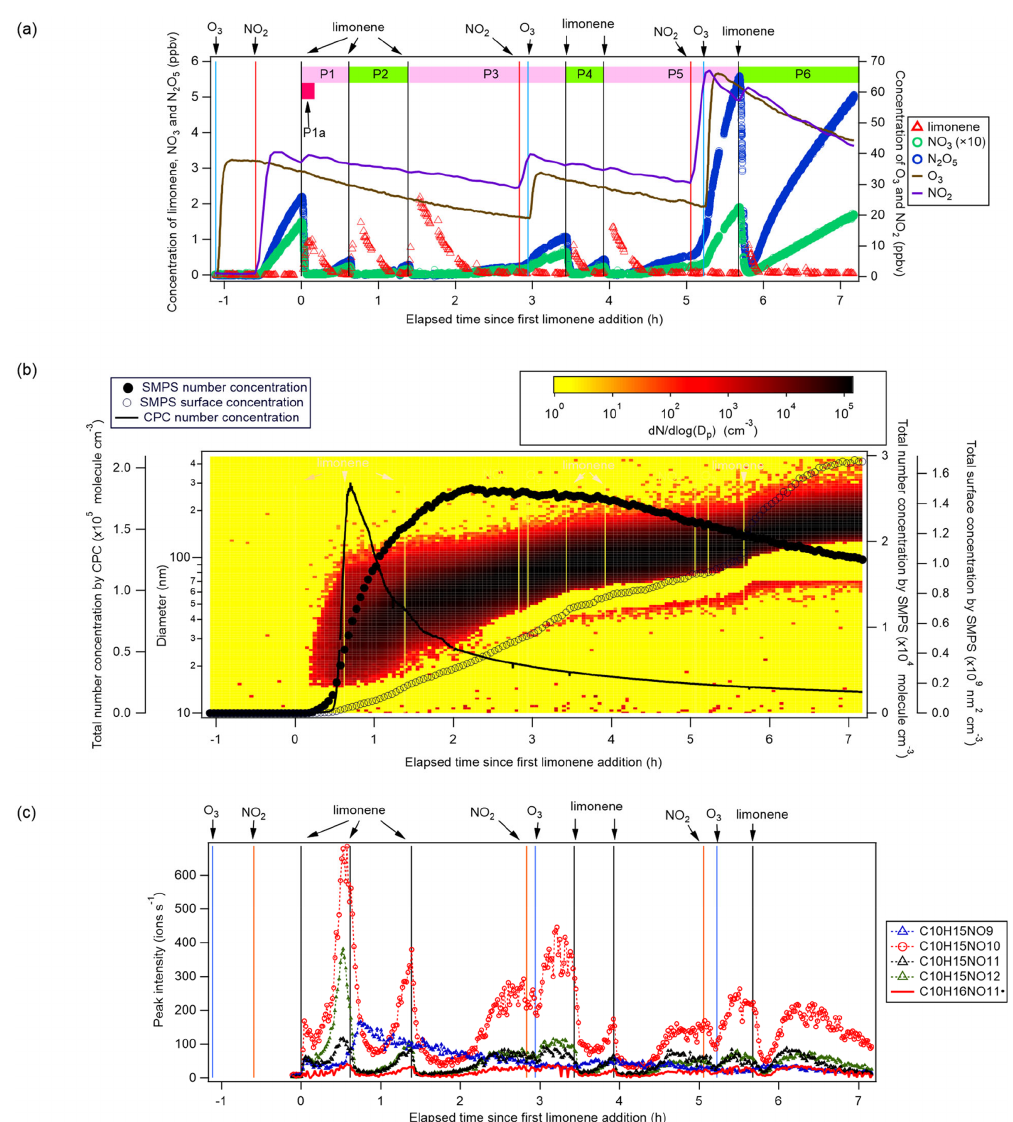
Figure 1. (a) Time series of the concentrations of limonene, NO 3 , and N 2 O 5 (left panel, the concentrations of NO 3 are magnified by a factor of 10 for clarity), and O 3 and NO 2 (right panel). The time periods P1 to P6 and P1a are also marked. (b) Total particle concentration and its size distribution during the whole period of experiment detected by SMPS and CPC. The solid and hollow black circles refer to total number concentration and total surface concentration detected by SMPS, respectively. Colors represent particle number concentration distribution based on log( D p ). The solid black line refers to total number concentration detected by CPC. (c) Time series of peak intensity of typical (cid:113) (cid:113) products of the C 10 H 15 NO x family and C 10 H 16 NO as a representative of the C 10 H 16 NO x family. Vertical lines indicate the time of O 3 11 and NO 2 additions, and six limonene